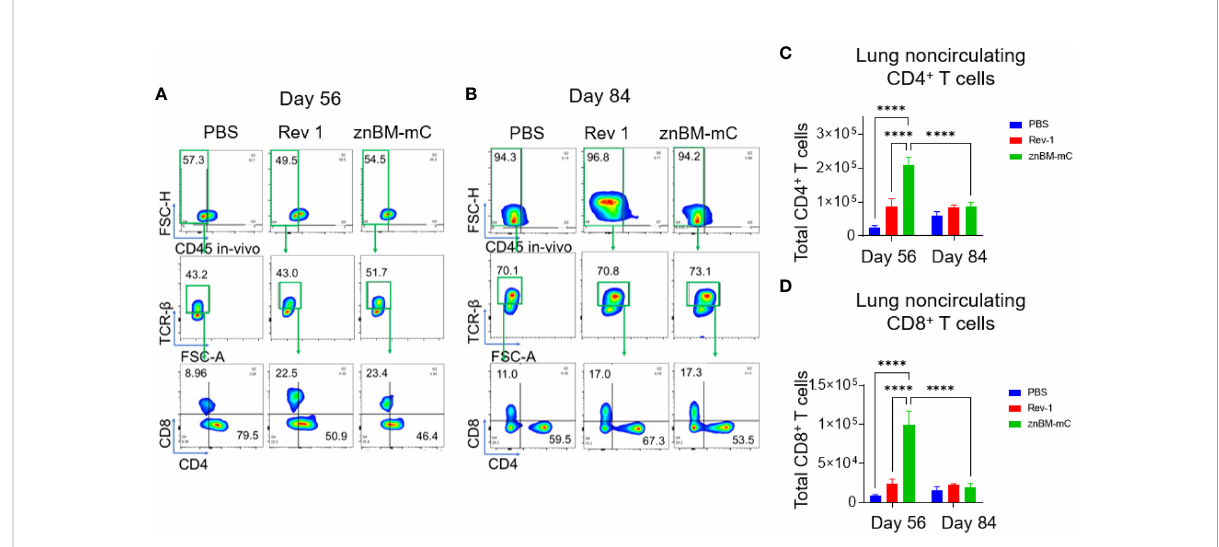
FIGURE 3 Oral prime, IN boost induces expansion of noncirculating lung CD4 + and CD8 + T cells, and these are reduced following a B. melitensis 16M challenge. Groups of mice were vaccinated with sPBS, Rev 1, or znBM-mC and then subjected to pulmonary challenge with 5 × 10 4 CFUs wt B. melitensis 16M as described in Figure 2. On days 56 and 84, lung lymphocytes were isolated and stained for fl ow cytometry analysis. All mice were given a retroorbital injection of fl uorochrome-labeled anti-CD45 mAb 10 min prior to euthanasia. Representative FACS plots of lung T-cell subsets show noncirculating T cells identi fi ed as IV CD45 − cells on days (A) 56 and (B) 84, gated as TCR b + cells, and then gated as CD4 + and CD8 + T-cell subsets. After vaccination, both groups showed a signi fi cant increase in (C) CD4 + and (D) CD8 + T cells in the lungs compared to PBS-dosed mice. One-way ANOVA was used for statistical analysis; ****p <0.0001 vs. sPBS-dosed